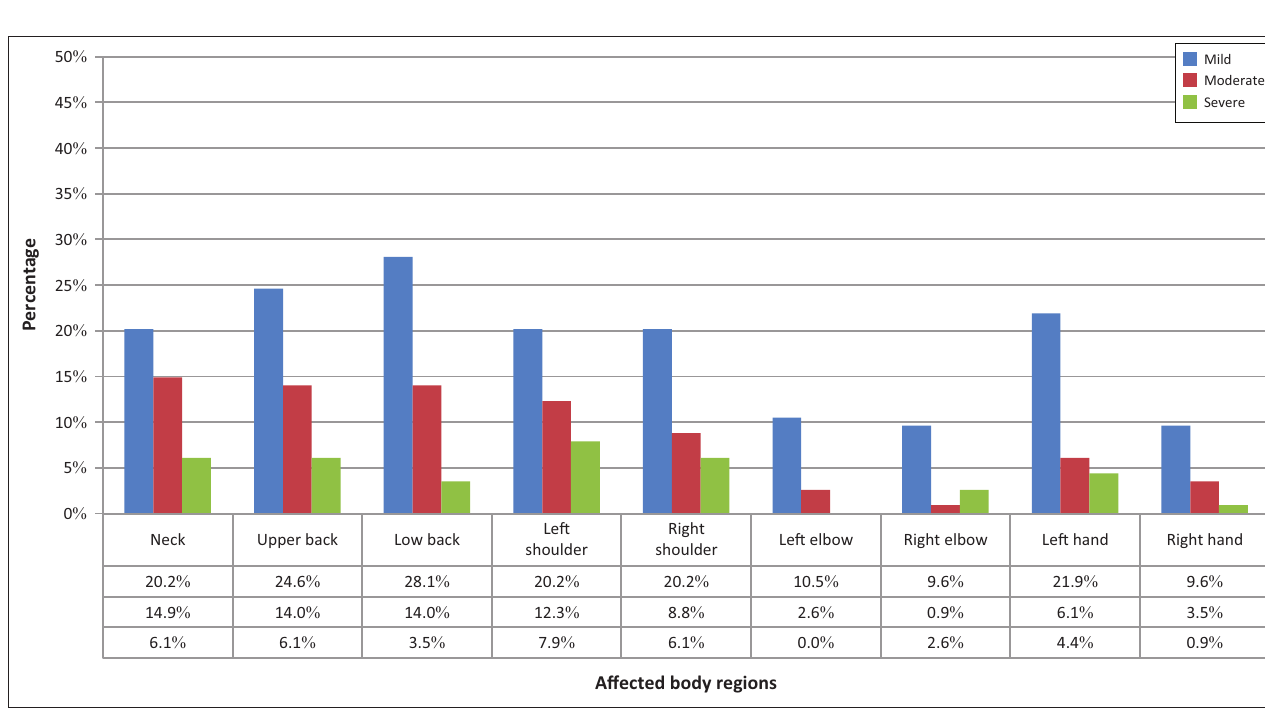
FIGURE 3: Distribution of musculoskeletal problems in the nine anatomic regions in lower string instrumentalists.